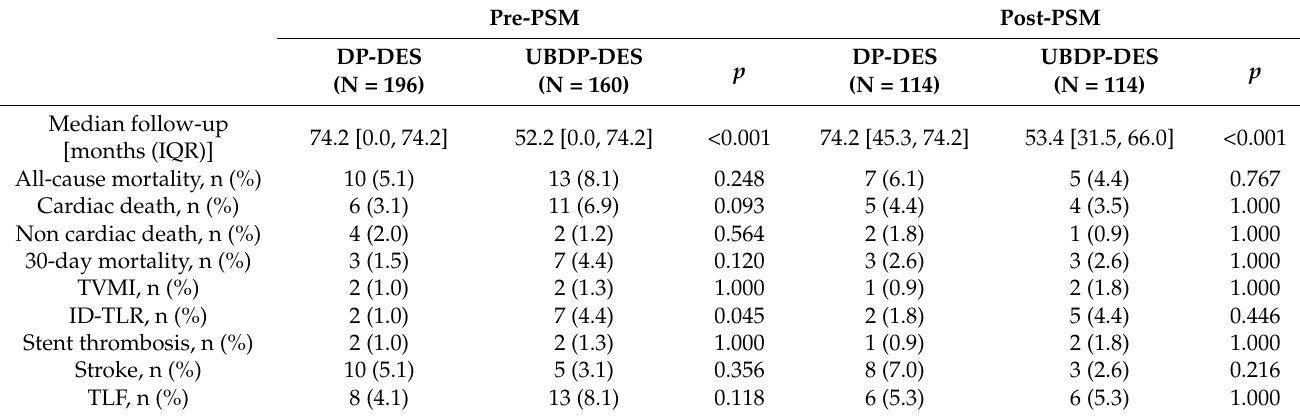
Table 4. Clinical events pre- and